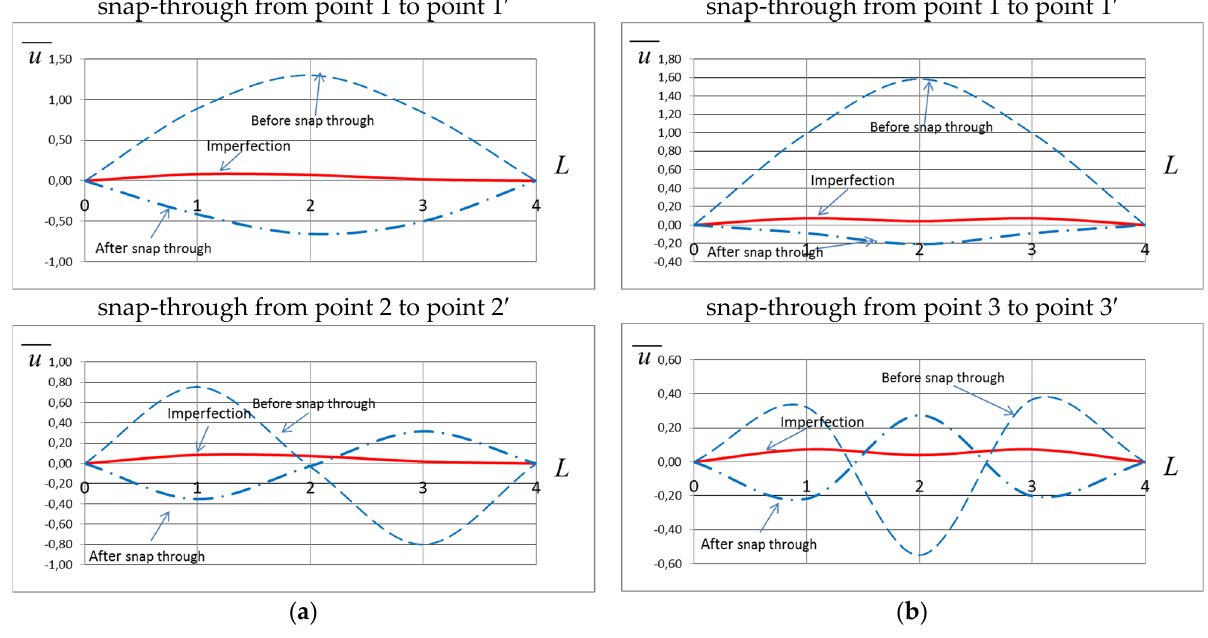
Figure 18. Configuration of displacement before and after snap-through for initial amplitudes of geometrical imperfections developed according to the first and second or third buckling mode; ( a ) d 1 s 2, ( b ) d 1 s 3.